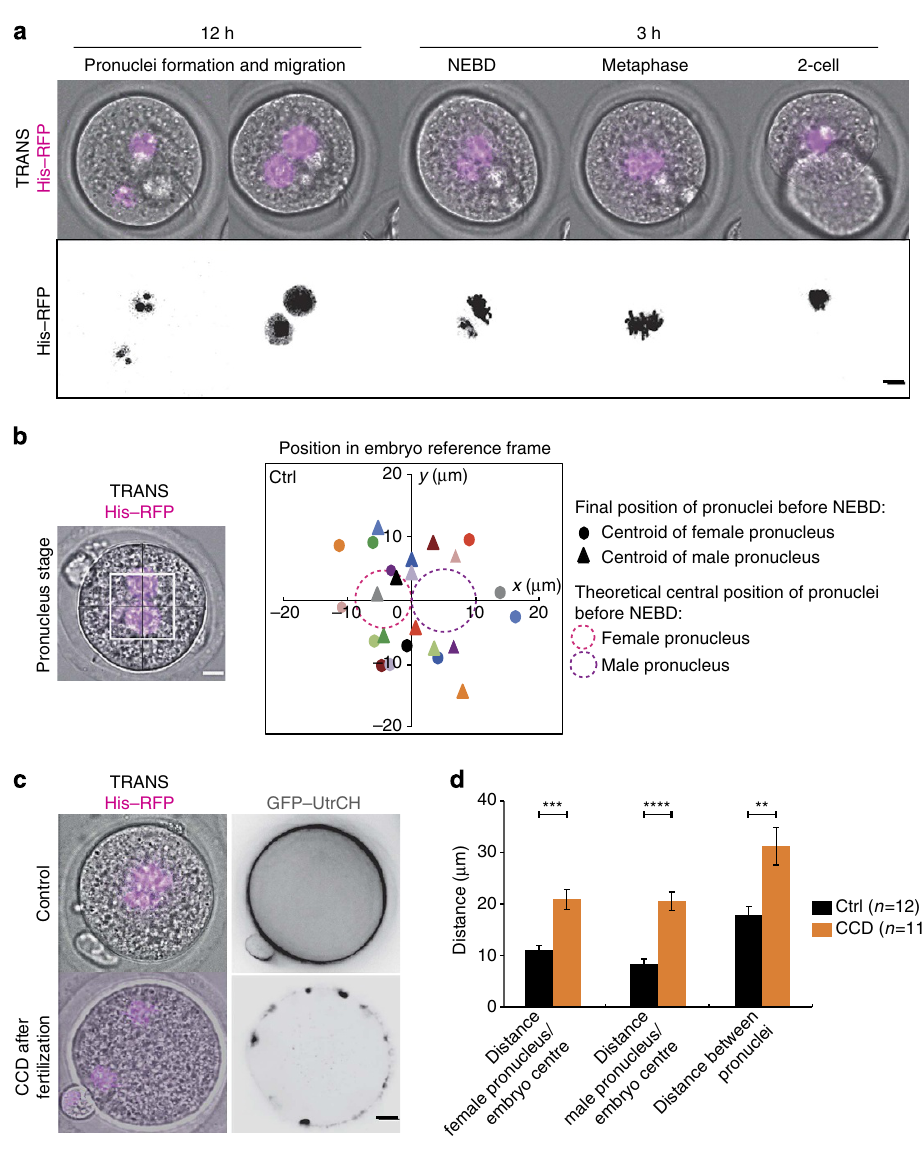
Figure 1 | The coarse centring of the two pronuclei is F-actin dependent. ( a ) Control embryo expressing His–RFP (upper panel: purple, overlay on transmitted light, Z-projection over 20 m m; lower panel: black). The first two frames are 12h apart then one picture is shown every 1h (Scale bar: 10 m m). ( b ) Left panel: control embryo expressing His–RFP (purple, overlay on transmitted light, Z-projection over 20 m m) at the Pronucleus stage (scale bar, 10 m m). Right panel: dot plot showing the position of the centroid of the two pronuclei in the referential of the embryo (0 being the centre) 1h before NEBD for 10 control embryos. The scale is represented by the white box on the left panel. Each colour represents an embryo, the circle is the female pronucleus and the triangle is the male pronucleus. The mean size of the maternal (pink) and paternal (purple) pronuclei is represented by the two dotted circles at the embryo centre. ( c ) Embryos just after NEBD expressing His–RFP (left panel, purple, overlay on transmitted light, Z-projection over 20 m m) and GFP–utrCH (right panel, black, one Z-plane is shown). Upper panel: control embryo; lower panel: embryo treated during pronuclei migration with 1 m gml (cid:2) 1 Cytochalasin D (CCD). Scale bar, 10 m m. ( d ) Bar graph showing the male and female pronuclei distance to the embryo centre and to each other at NEBD for control embryos (black bars) or embryos treated during pronuclei migration with 1 m gml (cid:2) 1 CCD (orange bars). Mean is shown of 12 controls and 11 CCD-treated embryos from 6 independent experiments. s.e.m. is plotted on each bar. Statistical significance of differences is assessed with t -test or t -test with Welch correction ( P values: female pronuclei/embryo centre: 0.0004; male pronuclei/embryo centre o 0.0001; between pronuclei: